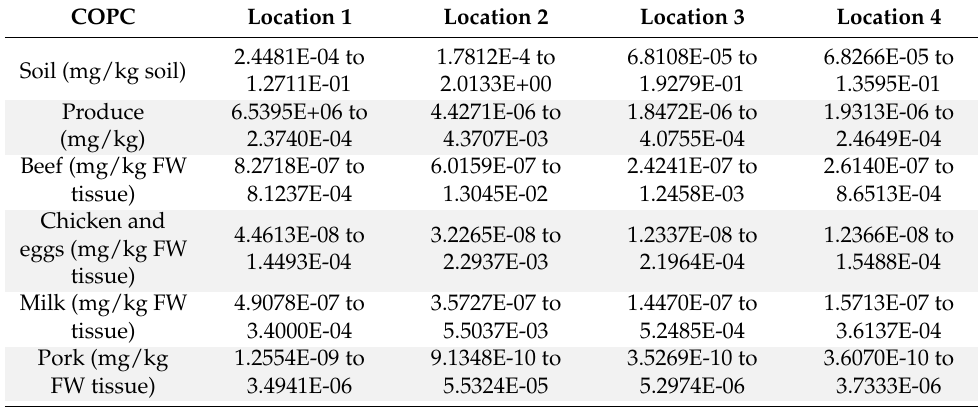
Table 8. Concentrations of COPCs evaluated in locations 1, 2, 3 and